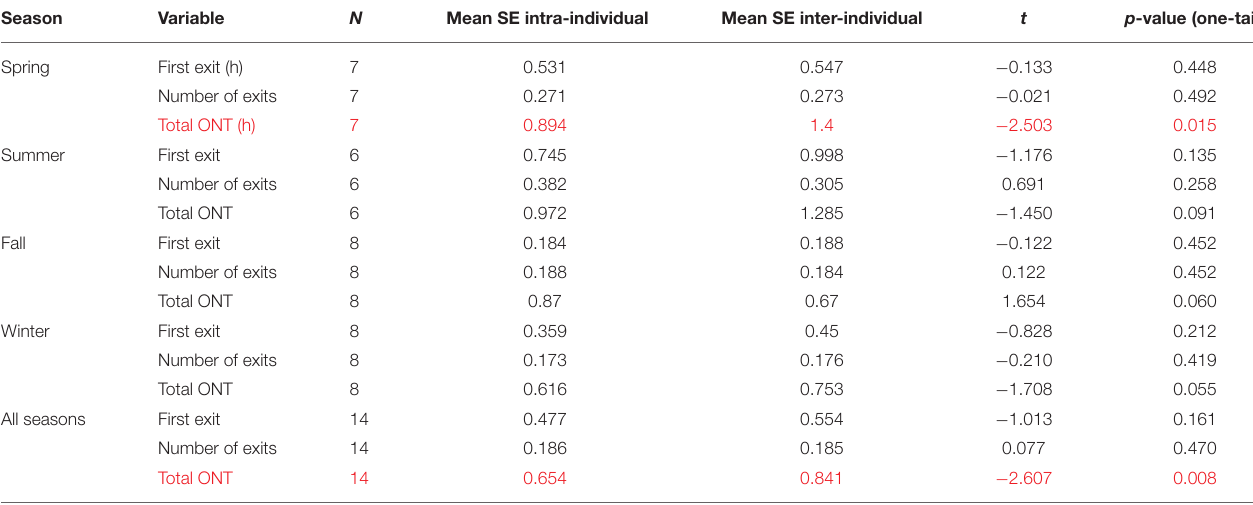
TABLE 5 | Comparison between the intra-individual and inter-individual variation in three variables. Season Variable N Mean SE intra-individual Mean SE inter-individual t p -value